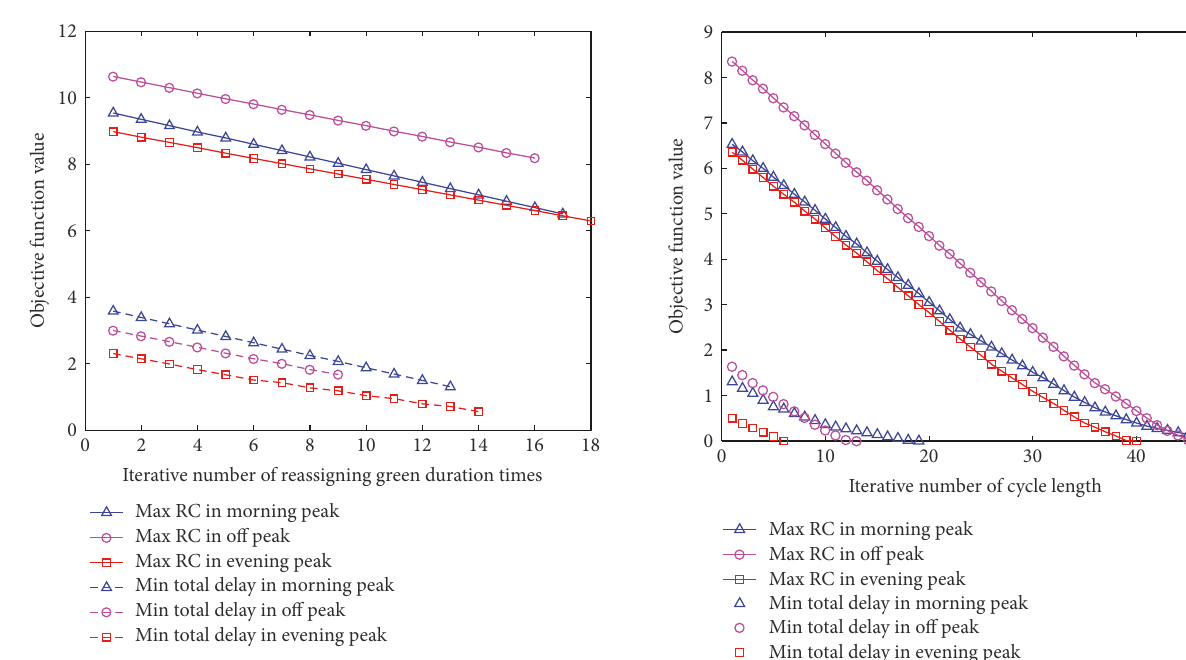
Figure 9: Optimization of the objective function values during the refinement process under a fixed cycle time, 𝜍 . Figure 10: Optimization of objective function values of signal refinement model with adjustable cycle